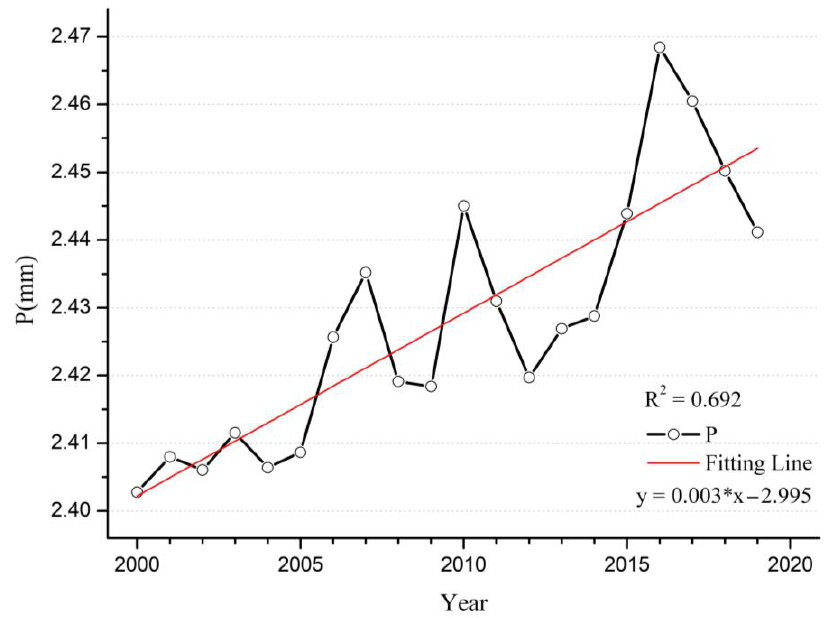
Figure 6. Time series of annual mean precipitation from 2000 to 2019.